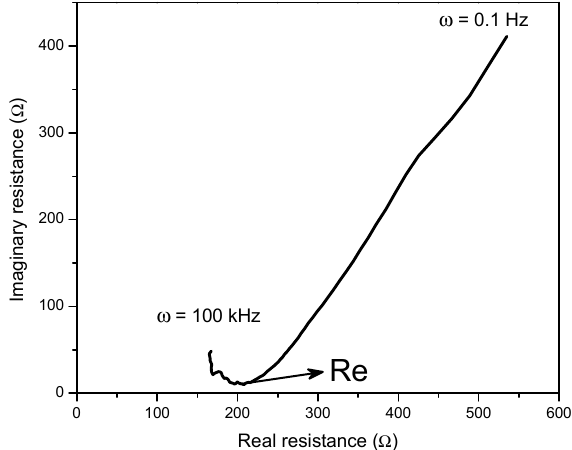
Figure 6. A typical Nyquist diagram of electrochemical impedance spectroscopy (EIS) studies at high frequencies.